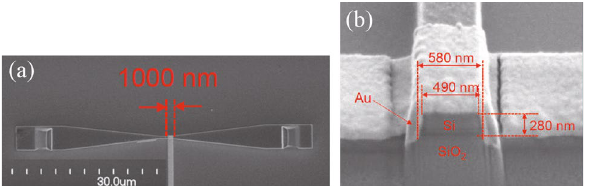
Figure 3. Scanning electron microscopy image of the fabricated structure with 1000 nm of the length of the hybrid plasmonic waveguide (L). ( a ) Image from the top and ( b ) a cross section of the hybrid plasmonic waveguide.